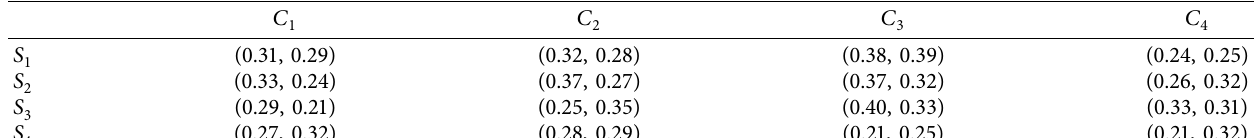
Table 4: Analysis of the variables involved in the collected questionnaires.